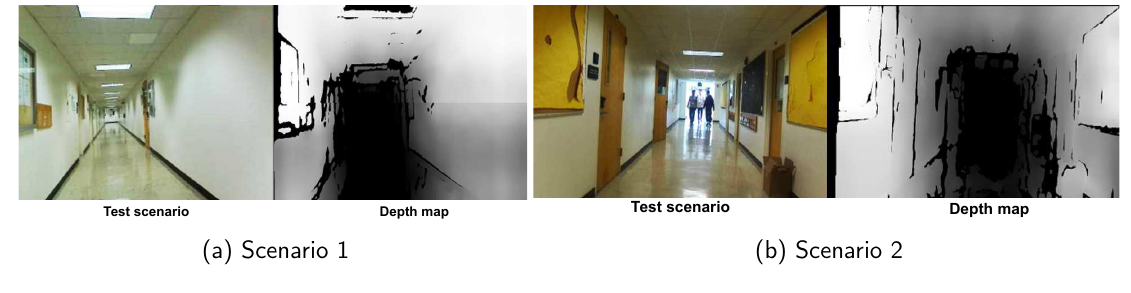
Figure 15. 3D mapping results of the